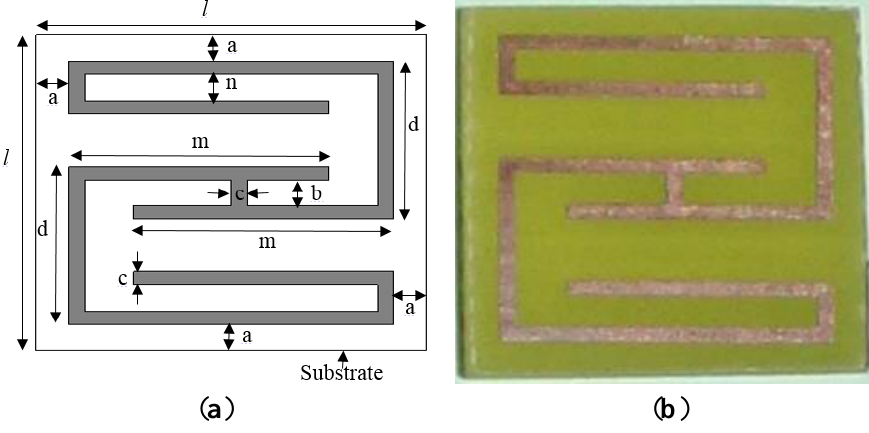
Figure 1. Metamaterial unit cell A: ( a ) proposed geometry; and ( b ) fabricated